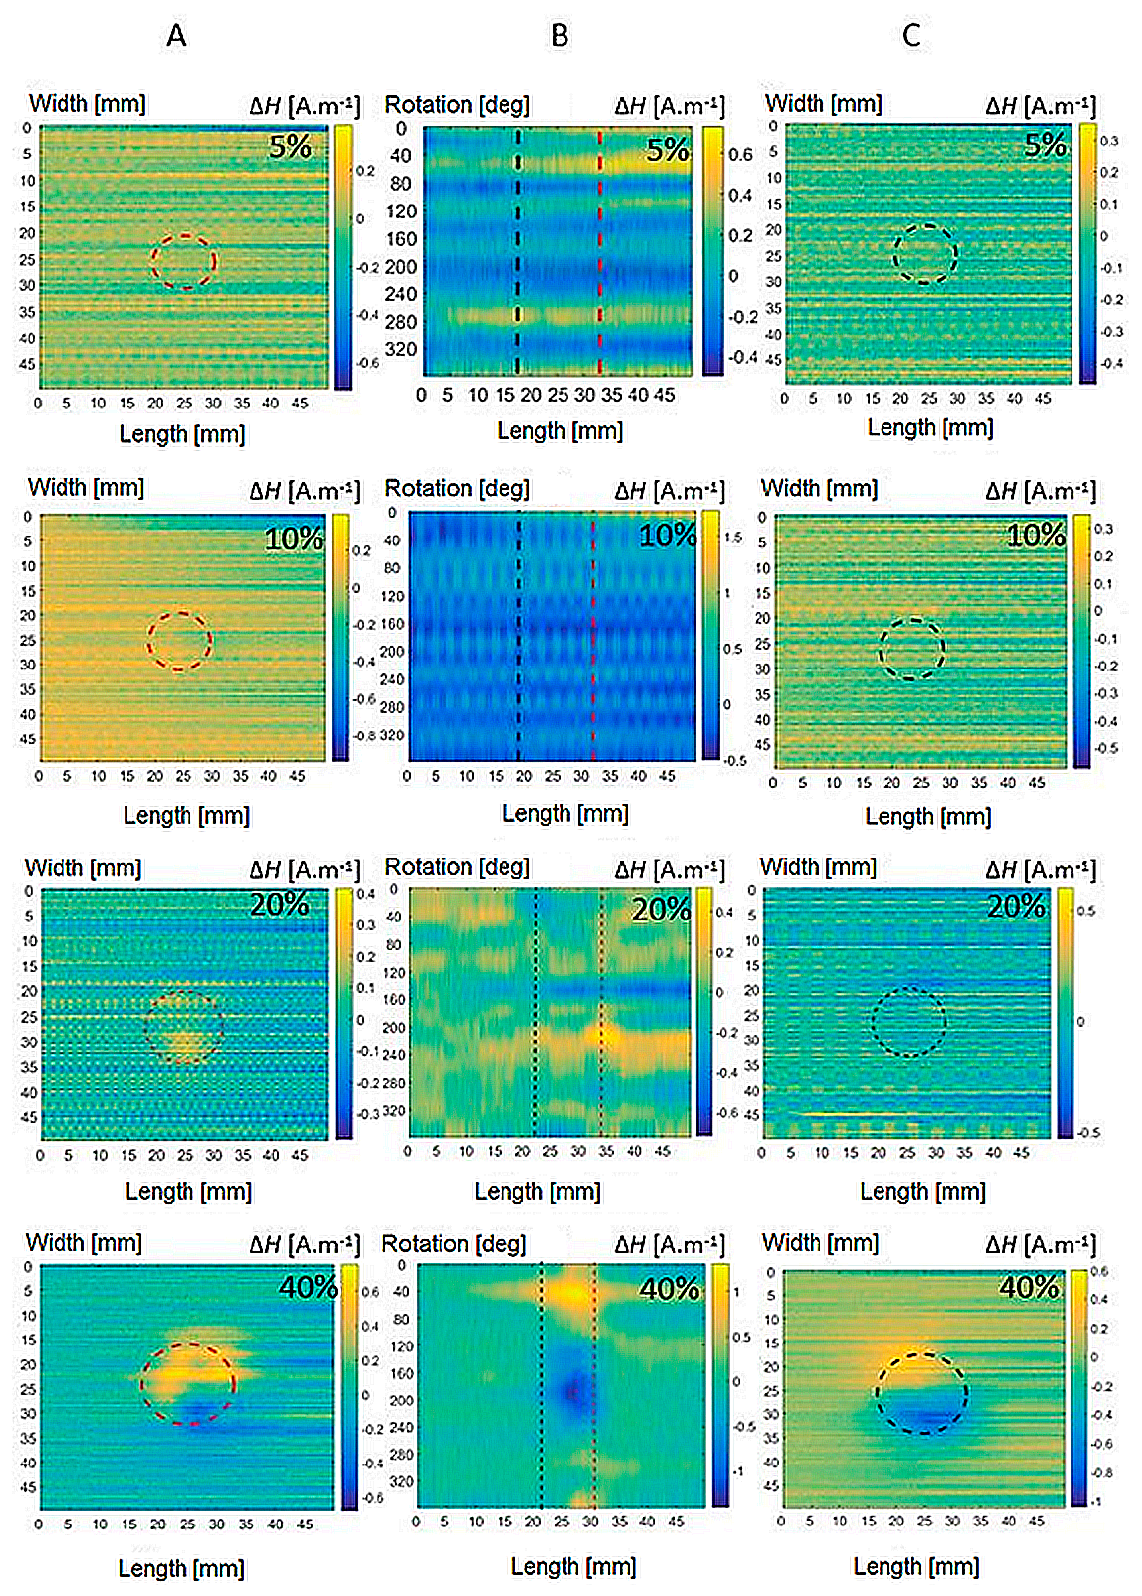
Figure 11. Magnetic field distribution of bases ( A , C ) and shell ( B ) of AISI 316L specimens of all plastic deformation.